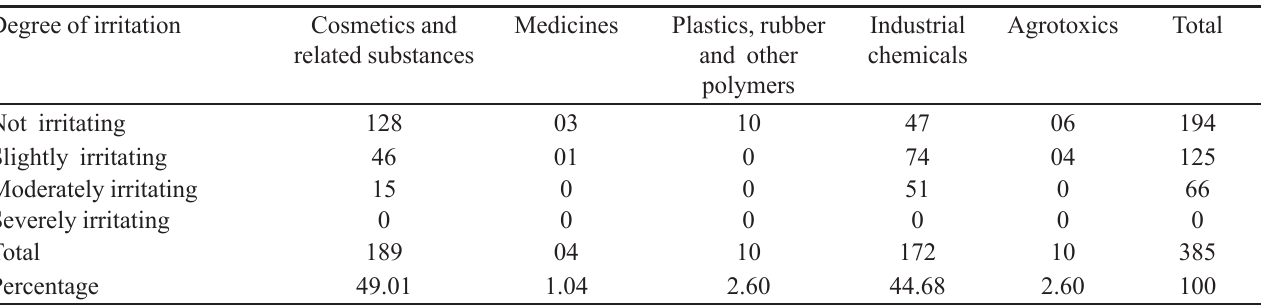
TABLE I – Number and percentage of assays for cutaneous irritation in guinea-pigs, according to the degree of irritation and type of agent assayed a